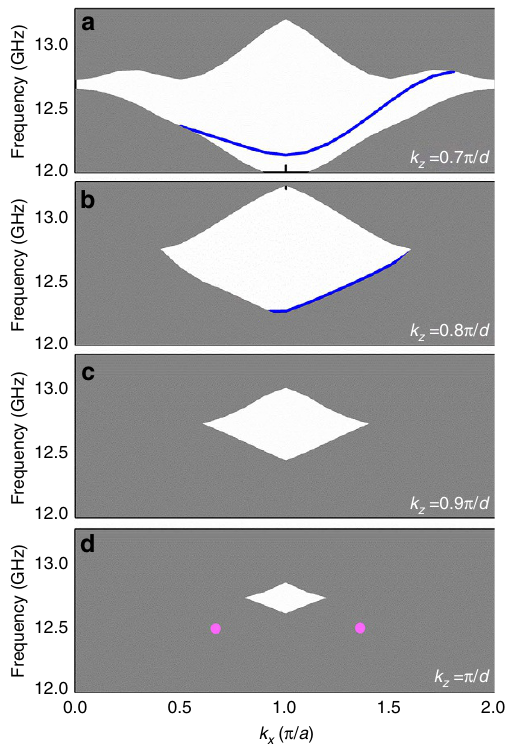
Figure 6 | Surface-projected band when ( a ) k z ¼ 0.7 p / d , ( b ) k z ¼ 0.8 p / d , ( c ) k z ¼ 0.9 p / d and ( d ) k z ¼ p / d . The two pink solid circles highlight the Weyl points between the fourth and fifth bands at H and H 0